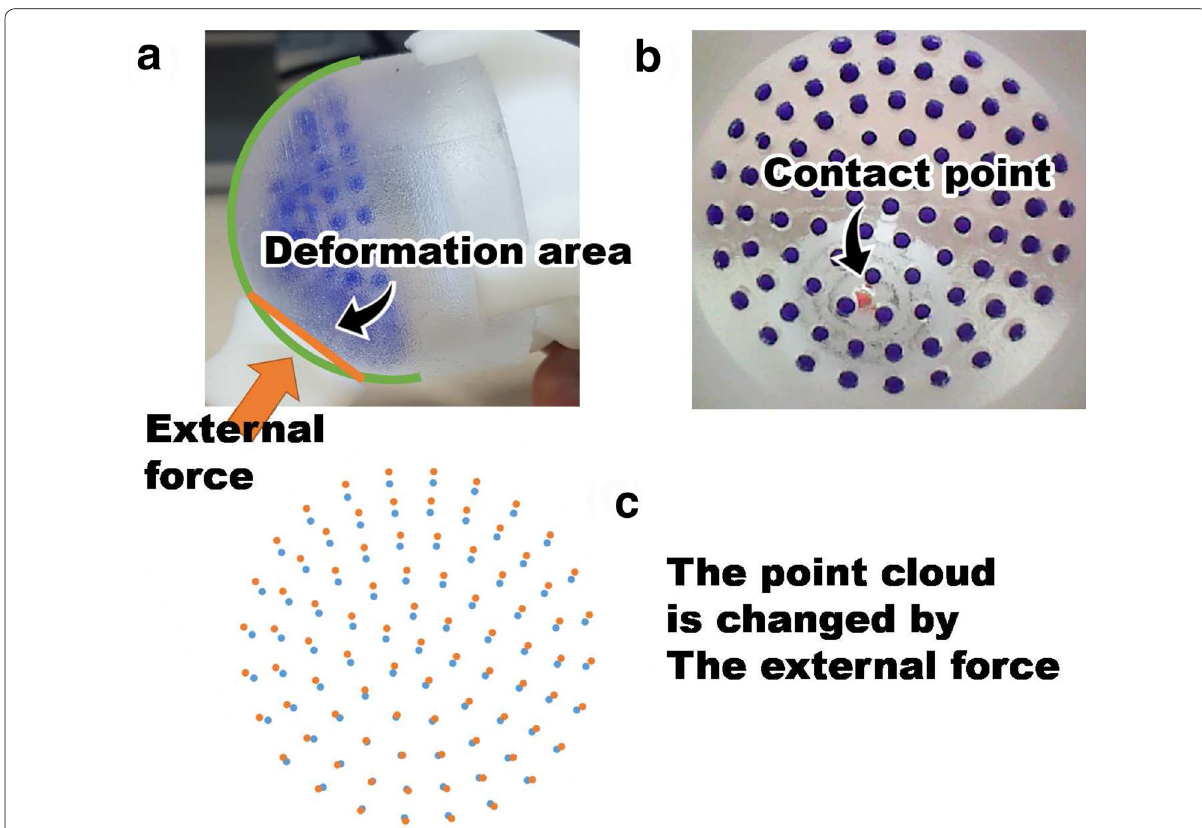
Fig. 3 Deformation of the position of the marker by an external force: a in case there is no deformation by the external force. b In case there is some deformation by the external force. c The contact position and the force can be determined by the change in point position caused by the external